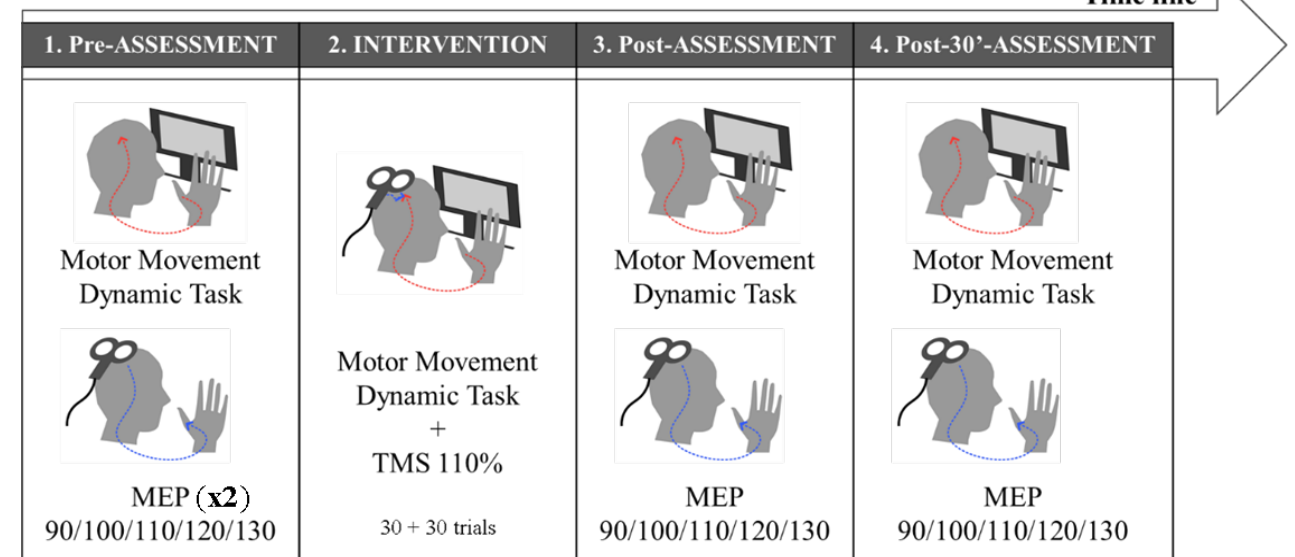
Figure 2. Experimental timeline design: 1. Pre-assessment: motor performance indices and the MEP recruitment curve assessment, evaluated twice. 2. Intervention: we applied the PAS protocol synchronizing thumb movement with a TMS pulse. 3. Post-Assessment: we assessed motor performance indices and the motor pathway excitability changes. 4. Post-30’-Assessment: 30 min after the intervention, we assessed the motor performance indices and motor pathway excitability.